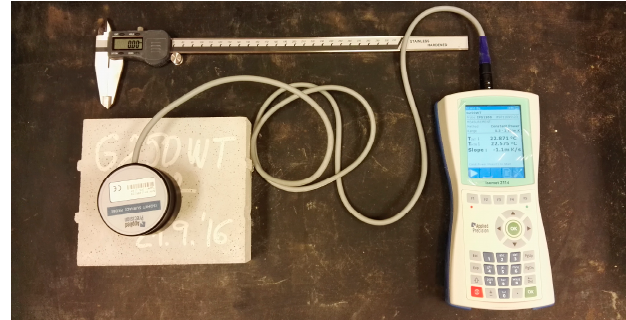
Figure 2. Thermal conductivity measurement of cement composites based on recycled waste paper.